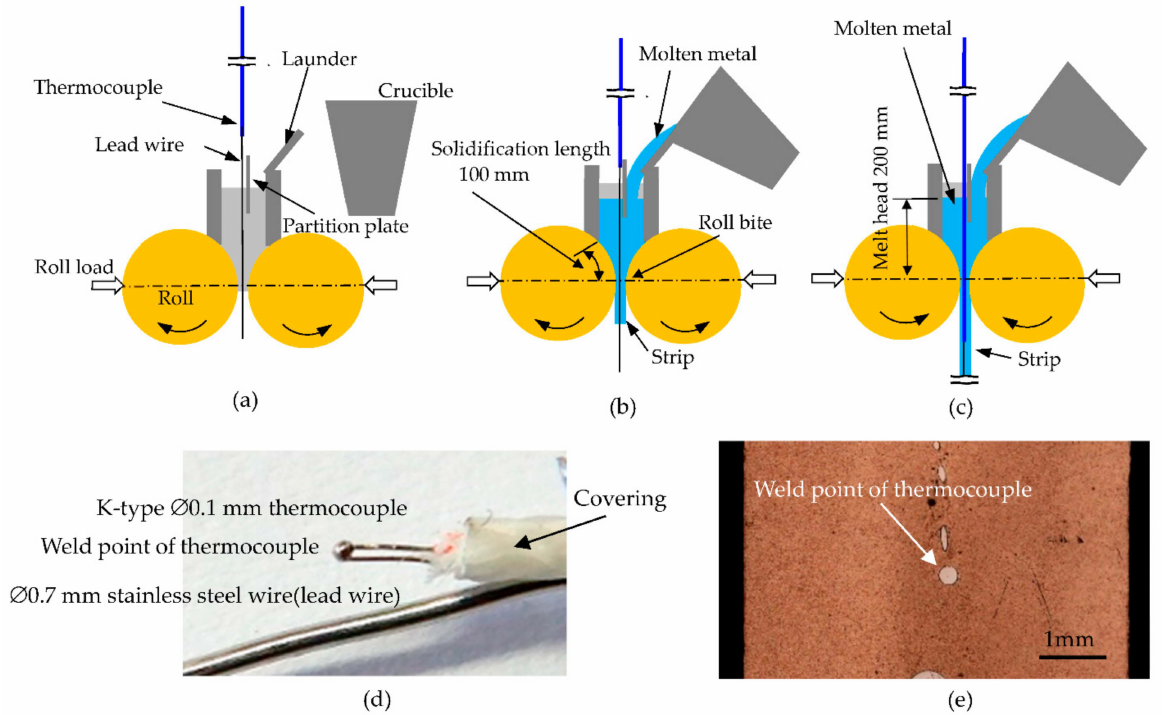
Figure 1. Experimental procedure for inserting thermocouple into strip, thermocouple with lead wire, and tip of inserted thermocouple. ( a – c ) Insertion procedure for thermocouple, ( d ) tip of thermocouple and lead wire, and ( e ) tip of thermocouple inserted in strip.